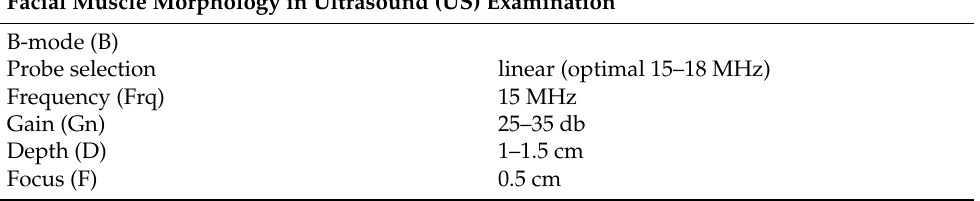
Table 2. High-resolution ultrasound (HRUS) settings to examine the functionality and morphology of facial muscles. The following settings allow for the precise assessment of morphological and functional features during a facial muscle